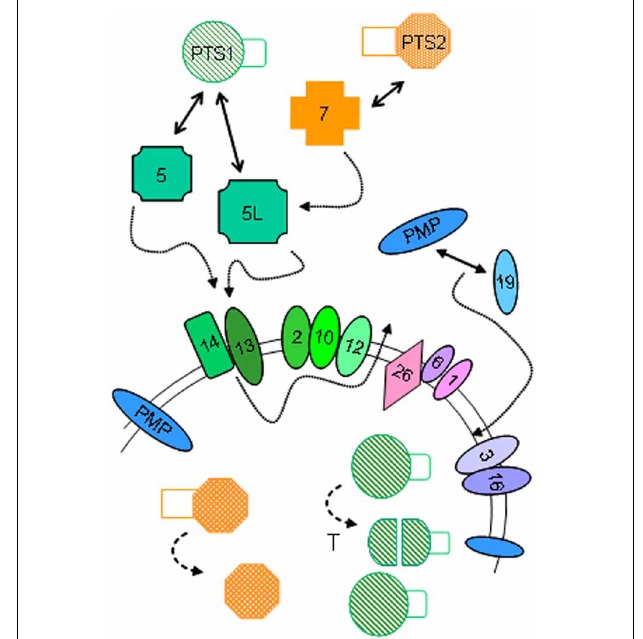
FIGURE 4 | Peroxisome biogenesis in animals. Simplified scheme for the import of PTS1-proteins, PTS2-proteins and integral peroxisomal membrane proteins (PMP) in animals and the involved peroxins, indicated by their PEX number. Role of ubiquitination of PEX5 and farnesylation of PEX19 is not shown. After import, some PTS1-proteins are processed by TYSND1, a peroxisomal protease (T), while the signal peptide of PTS2-proteins is cleaved off. Adapted from Van Veldhoven